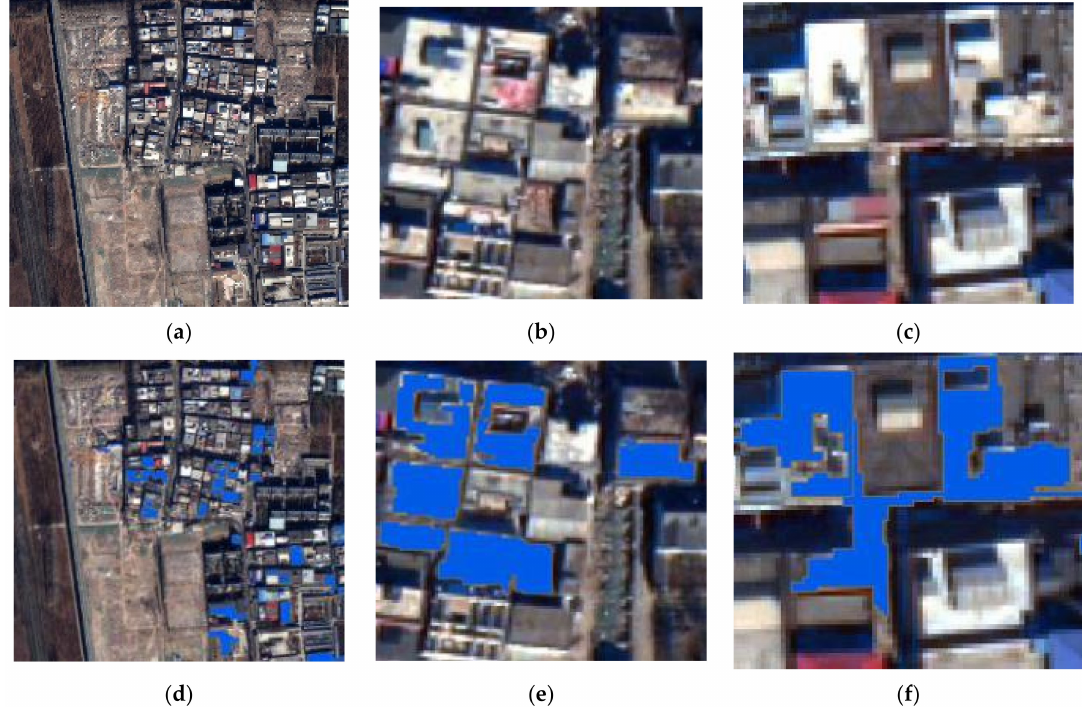
Figure 19. Classification results for GLCM standard deviation: ( a – f ) the classification result graphed by the standard deviation eigenfunction of